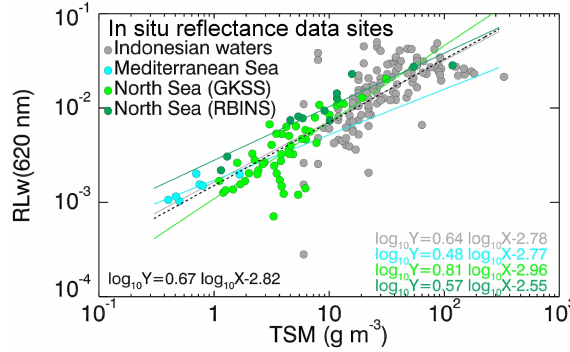
Figure 26. TSM (gm − 3 ) vs. RLw (620nm) from the CCRR in situ reflectance data set and their associated regression